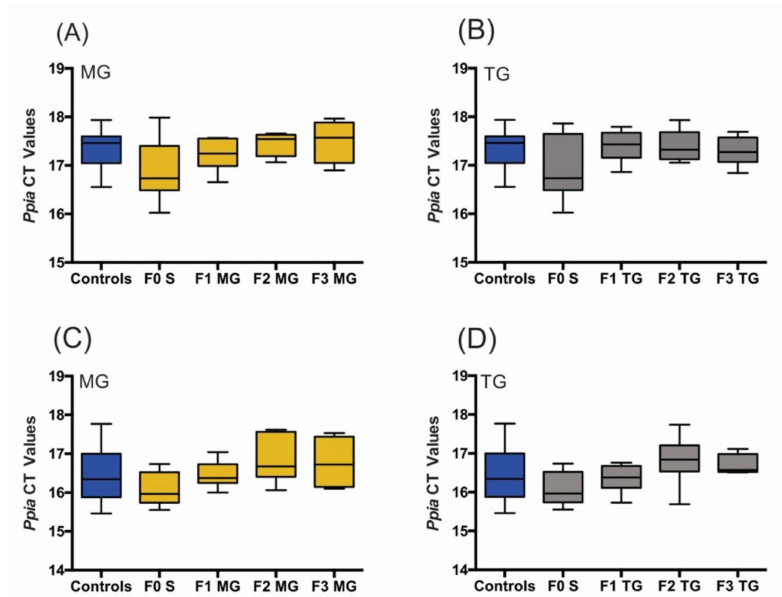
Figure A1. Expression levels of Ppia (CT values). No differences were found between generations and stress protocols (TG and MG) using ordinary one-way ANOVA. ( A , B ) Batch 1; ( C , D ) Batch 2. N numbers: Controls n = 20–31; F0 n = 8–10; F1 n = 5–8, F2 + F3 n = 4–12. Mean ±